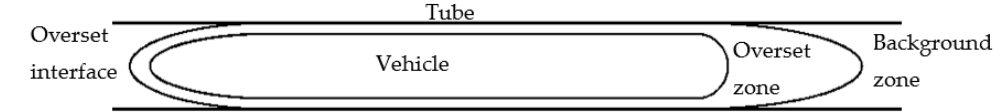
(Figure 5): a stationary subdomain defined by the tube (Figure 5a) and a moving subdo- main (Figure 5b) surrounding the vehicle in close proximity.